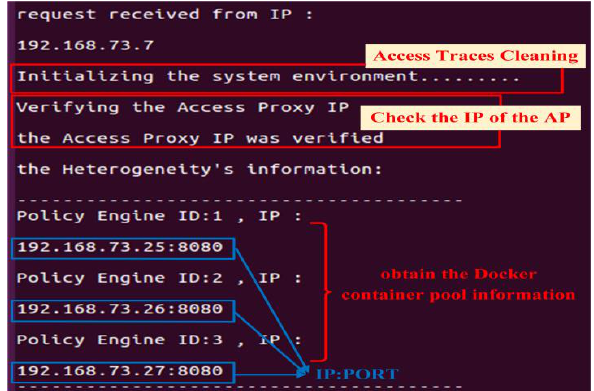
Figure 13. Check AP and query IP.